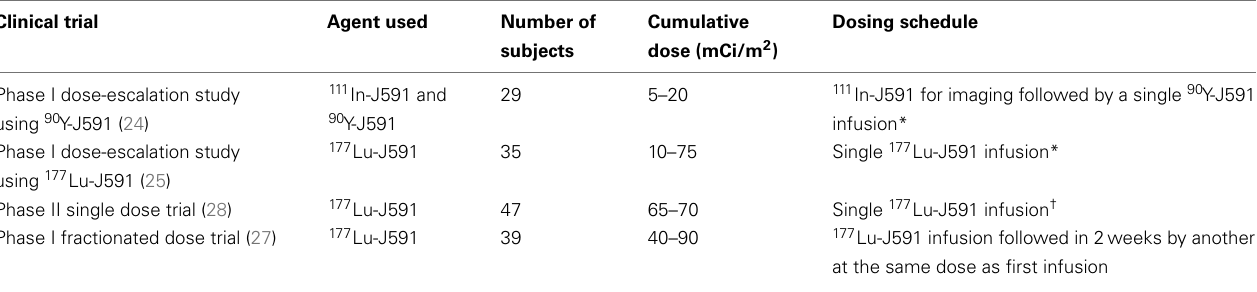
Table 1 | Radiolabeled-J591 clinical studies